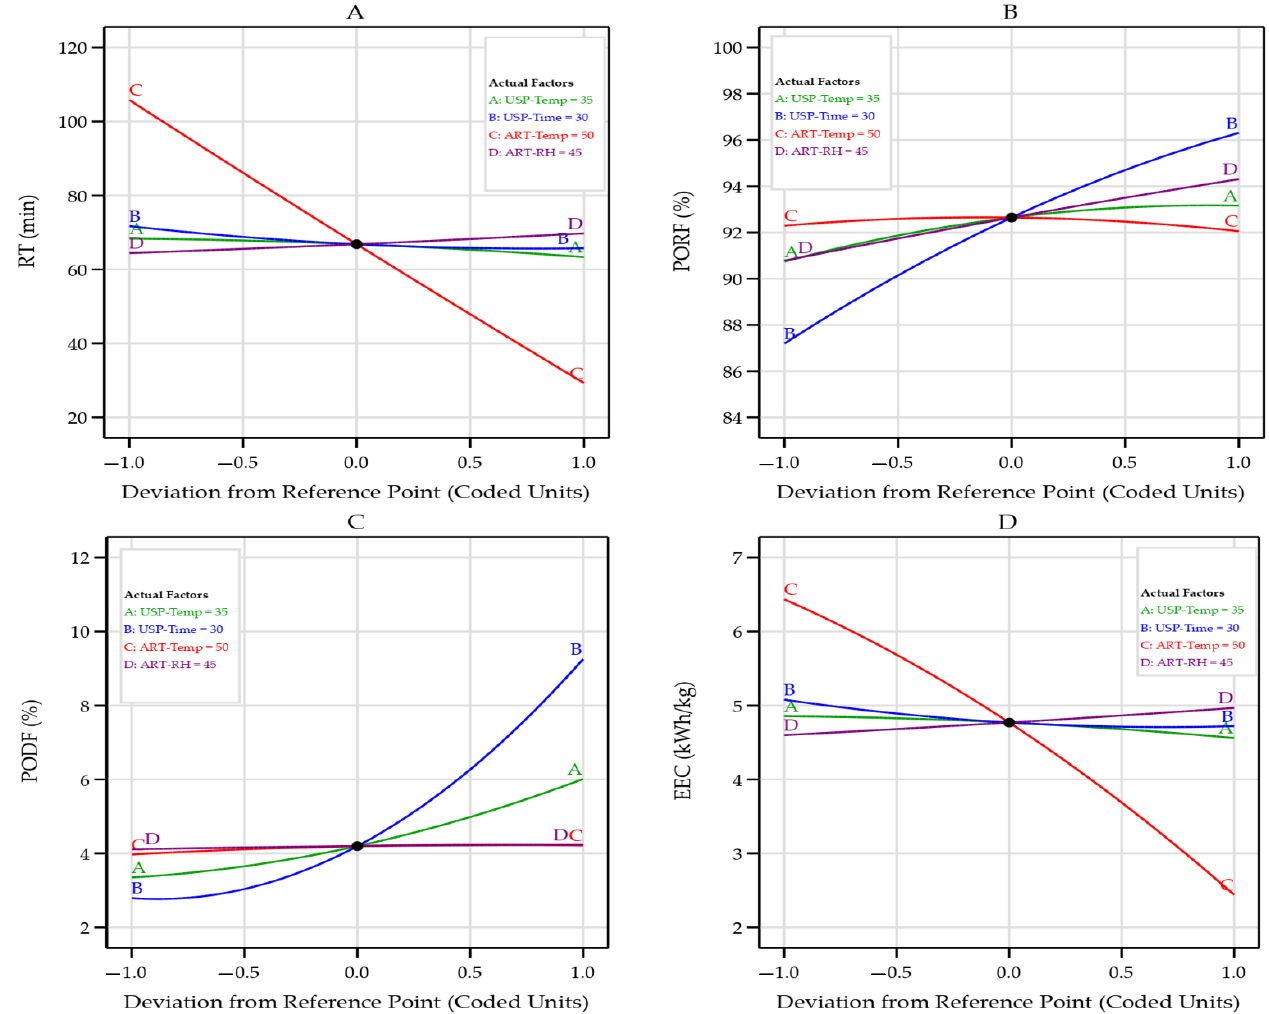
Figure 7. The perturbation plot displays the effect of ultrasound pretreatment time ((A): USP-Temp), ultrasound pretreatment temperature ((B): USP-Time), ripening treatment temperature ((C): ART- Temp), and ripening treatment RH ((D): ART-RH) factors on the required time for fruit ripening (RT) (Graph ( A )), percentage of ripe fruit (PODF) (Graph ( B )), percentage of damaged fruit (PODF) (Graph ( C )), and electrical energy consumption (EEC) (Graph ( D